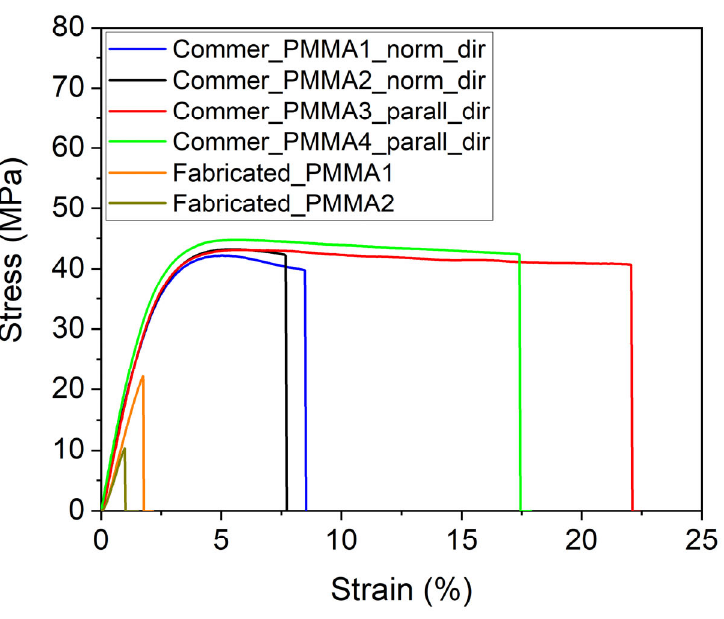
Figure 6. Tensile strength of PMMA commercial foil in both normal and parallel directions and prepared foils (1 and 2 from 1/24 and 1/18 mL). (Three samples are tested for the analysis.) However, two ‐ sample test results are